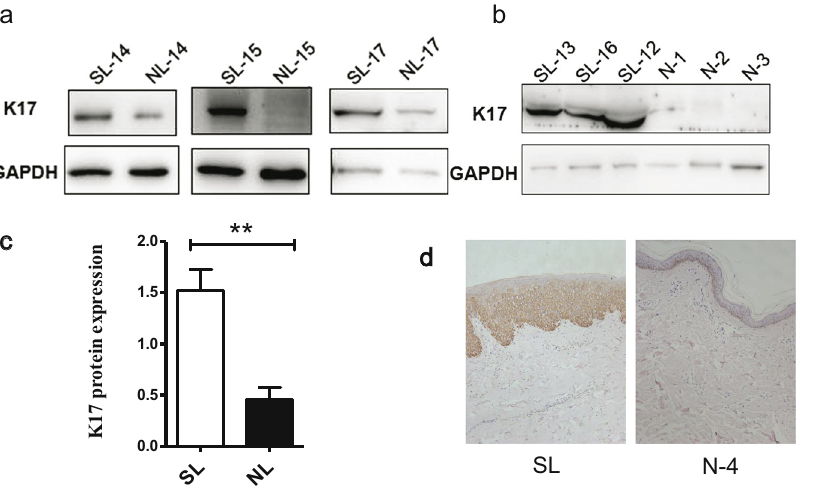
Figure 4: K17 expression is elevated in PN lesional skin. ( a ) Protein levels of K17 were detected in lesional skin and perilesional skin of patients with PN ( n = 10 ) by Western blot and ( b ) protein levels of K17 from patients with PN and healthy controls ( n = 9 ) ; ( c ) Image J analysis of K17 protein levels in lesional and perilesional skin. Band intensity was quanti fi ed by Image J. Values presented are the average of the K17 protein levels normalized to GAPDH from ten patients. ( d ) K17 expression in the PN lesional skin sample. Representative images of K17 expression are shown at 200 × magni fi cation. SL, lesional skin; NL, perilesional skin; and N, normal control. ** P < 0.01, by paired Student ’ s t test.